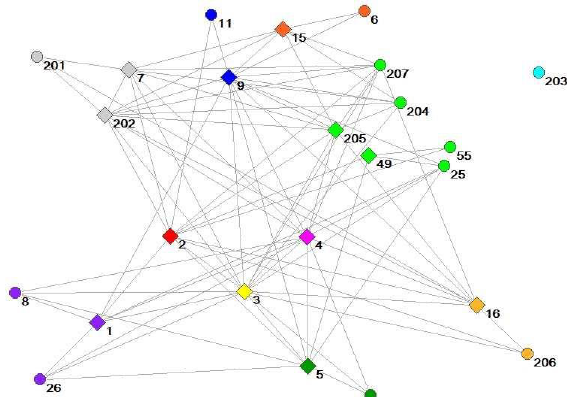
Fig.14. Florence's network in 1998, with colours indicating the deconstruction stages This is one of the networks with the highest degree